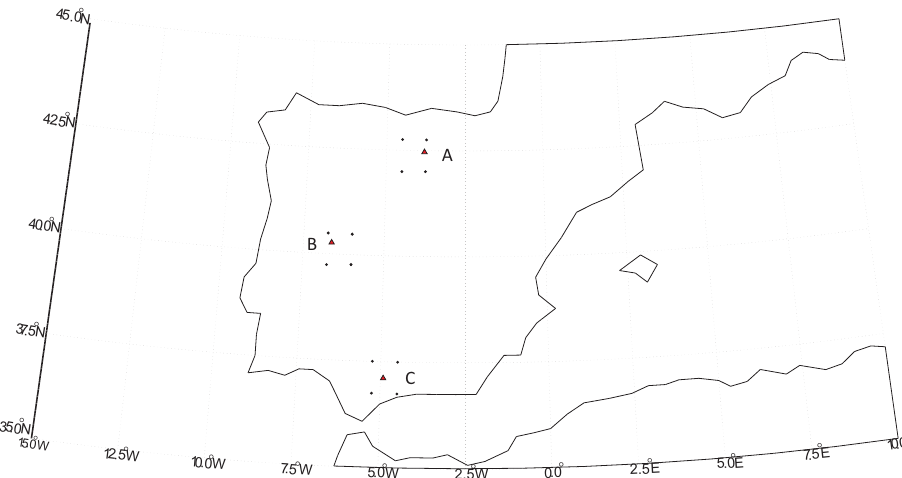
Figure 1. Representation of the geographical location of the wind farms (labeled “A”, “B” and “C”) considered in the experimental work carried out in this paper. The four closest nodes from the Era-Interim reanalysis (predictive variables) have also been represented for illustrative purposes. The reason why these wind farms have been selected is that they cover different parts of Spain, north, center and south, characterized by different wind regimes.